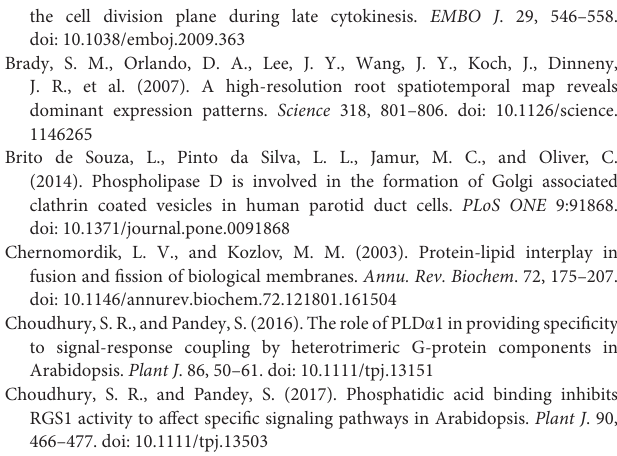
Figure S3 | PLD α 1-YFP localization in different tissues of the root tip of rescued pld α 1-2 mutant stably transformed with proPLD α 1::PLD α 1:YFP construct by light-sheet fluorescence microscopy. (A) Localization of PLD α 1-YFP in cells of the root tip counterstained by propidium iodide and merged image. Profiles at different positions of the root tip are visualized in orthogonal projections of radial root sections in (B) . Figure S4 | PLD α 1-YFP localization in trichoblast (labeled as T) and atrichoblast (labeled as A) rhizodermis cell files of the root tip of rescued pld α 1-1 mutant stably transformed with proPLD α 1::PLD α 1:YFP construct by light-sheet fluorescence microscopy. Localization of PLD α 1-YFP, propidium iodide and merged image of the root transition zone in longitudinal (A) and transversal (B) root projections. Figure S5 | PLD α 1-YFP localization in trichoblast (labeled as T) and atrichoblast (labeled as A) rhizodermis cell files of the root tip of rescued pld α 1-2 mutant stably transformed with proPLD α 1::PLD α 1:YFP construct by light-sheet fluorescence microscopy. Localization of PLD α 1-YFP, propidium iodide and merged image of the root transition zone in longitudinal (A) and transversal (B) root projections. Figure S6 | Immunofluorescence localization of PLD α 1 protein in Arabidopsis root meristem cells of wild type Col-0 seedlings showing homogeneous distribution of PLD α 1 in the cytoplasm. Figure S7 | Organization of microtubule arrays in dividing cells of root meristem in pld α 1-1 mutant in comparison to wild type Col-0. Arrowheads indicate PPBs, red arrows mitotic spindles and white arrows phragmoplasts. Immunofluorescence localization of microtubules with confocal microscopy, nuclei are counterstained with DAPI. Figure S8 | Immunofluorescence colocalization of microtubules with PLD α 1–YFP and clathrin in Arabidopsis root cells of complemented pld α 1-1 mutant expressing PLD α 1–YFP. (A) Colocalization of microtubules (green), PLD α 1–YFP (red), and clathrin (blue) in late phragmoplast of root meristematic cell during the cytokinesis. (B) Colocalization of cortical microtubules (green), PLD α 1–YFP (blue) and clathrin (red) in interphase root cell. Boxed areas in (B) are magnified in (C) . Arrows indicate colocalization of PLD α 1–YFP with clathrin in association with cortical microtubules. Video S1 | 3-D rendering of leaf epidermal petiole cell at the pre-prophase stage of cell division with established PPB and localization of PLD α 1-YFP. Video S2 | 3-D rendering of leaf epidermal petiole cell at the cytokinesis with ring phragmoplast and localization of PLD α 1-YFP. Video S3 | 3-D rendering of early disk phragmoplast in root meristematic cell at the cytokinesis with localization of PLD α 1-YFP. Video S4 | 3-D rendering of late ring phragmoplast in root meristematic cell at the cytokinesis with localization of PLD α